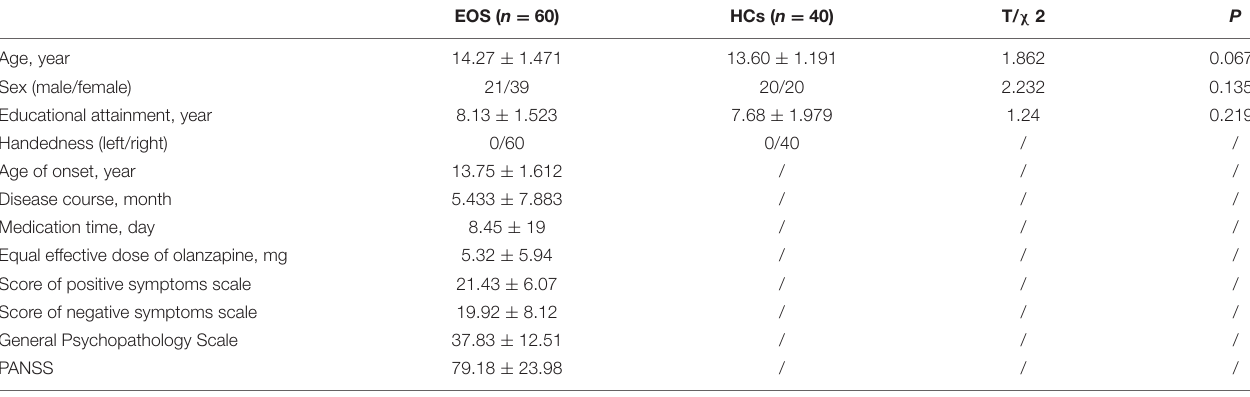
TABLE 1 | Demographic profile of early-onset schizophrenia (EOS) and healthy controls (HCs) [values are mean (S.D.)].